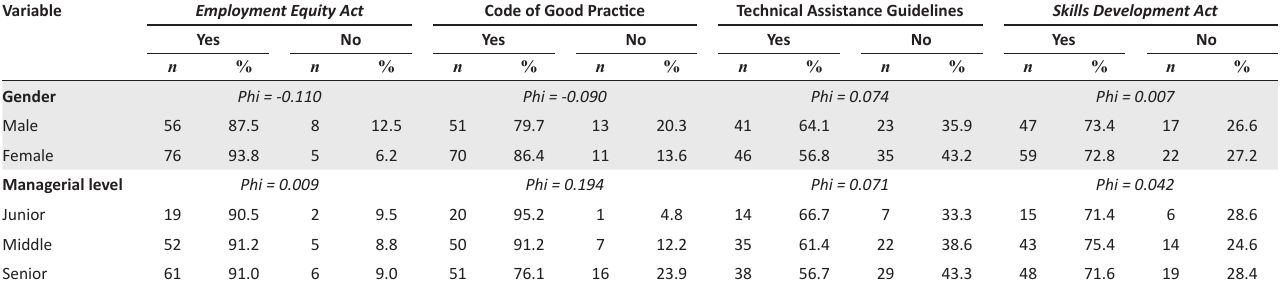
TABLE 8: Results of chi-square tests and descriptive statistics for familiarity and compliance with disability policies, guidelines and legislation that govern disability employment. Variable